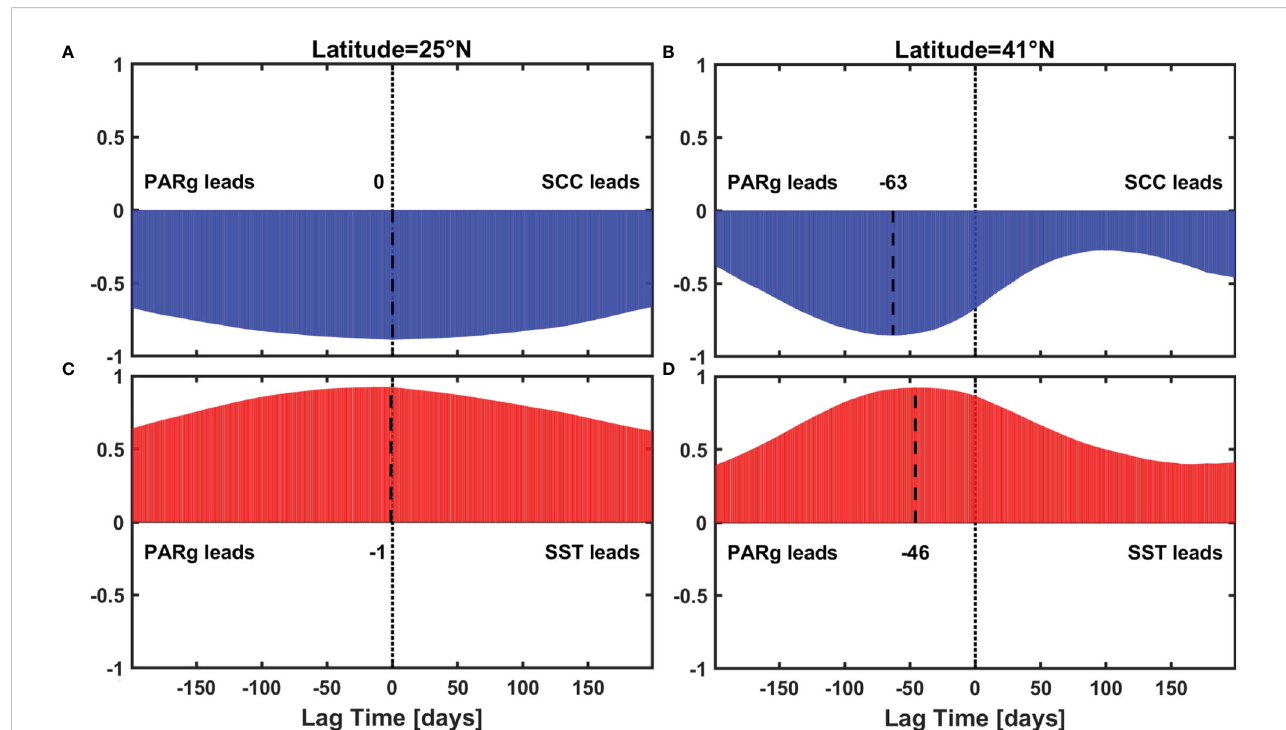
FIGURE 11 Lead-lag correlation result between (A) , (B) PARg and SCC (C) , (D) PARg and SST, black dash lines indicate the maximum